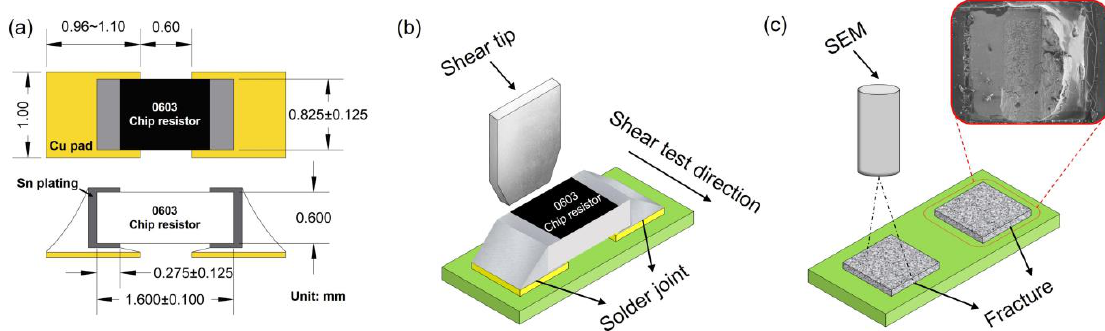
Figure 3. Schematic of ( a ) Parameters of component and copper pad; ( b ) Shear force test; ( c ) Fracture micromorphology observation by SEM.